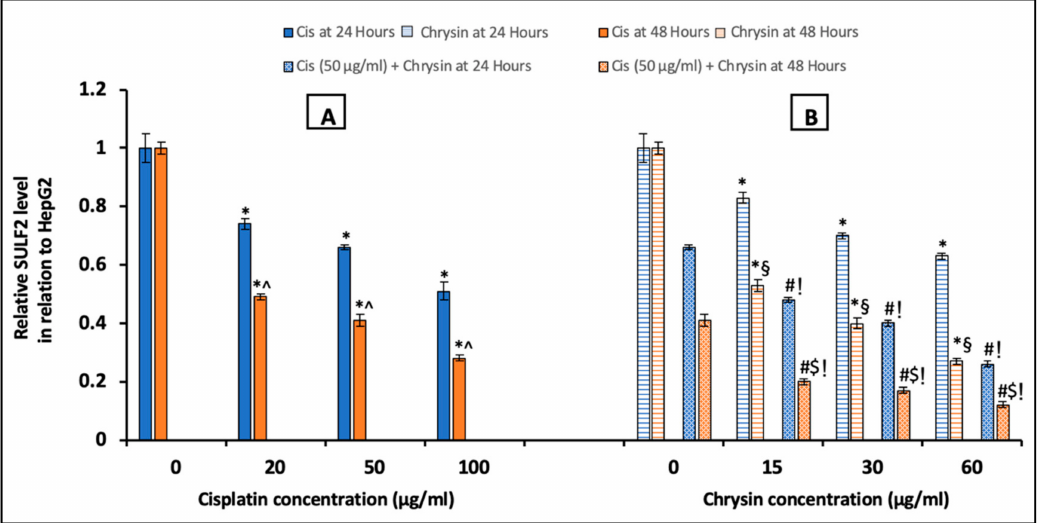
Figure 5. Impact of 24 and 48 h treatment with ( A ) cisplatin (Cis; 20, 50, 100 µ g / mL), ( B ) chrysin (15, 30, 60 µ g / mL) and combination of chrysin (15, 30, 60 µ g / mL) with Cis 50 µ g / mL on sulfatase-2 (SULF2) protein levels in HepG2 cells. Results are presented as Mean ± SD. * p < 0.05 versus the control untreated cells. ˆ p < 0.05 versus the same dose of Cis treatment for 24 h. # p < 0.05 versus the same dose of chrysin at the same incubation time. ! p < 0.05 versus Cis 50 µ g / mL at the same incubation time. § p < 0.05 versus the same dose of chrysin treatment for 24 h. $ p < 0.05 versus cis 50 µ g / mL + the same dose of chrysin treatment for 24